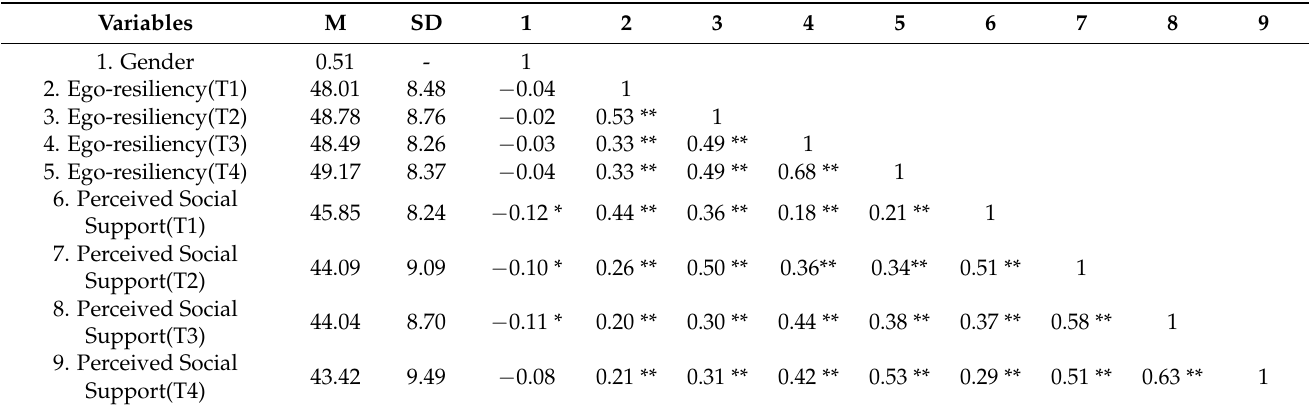
Table 1. Descriptive Statistics and